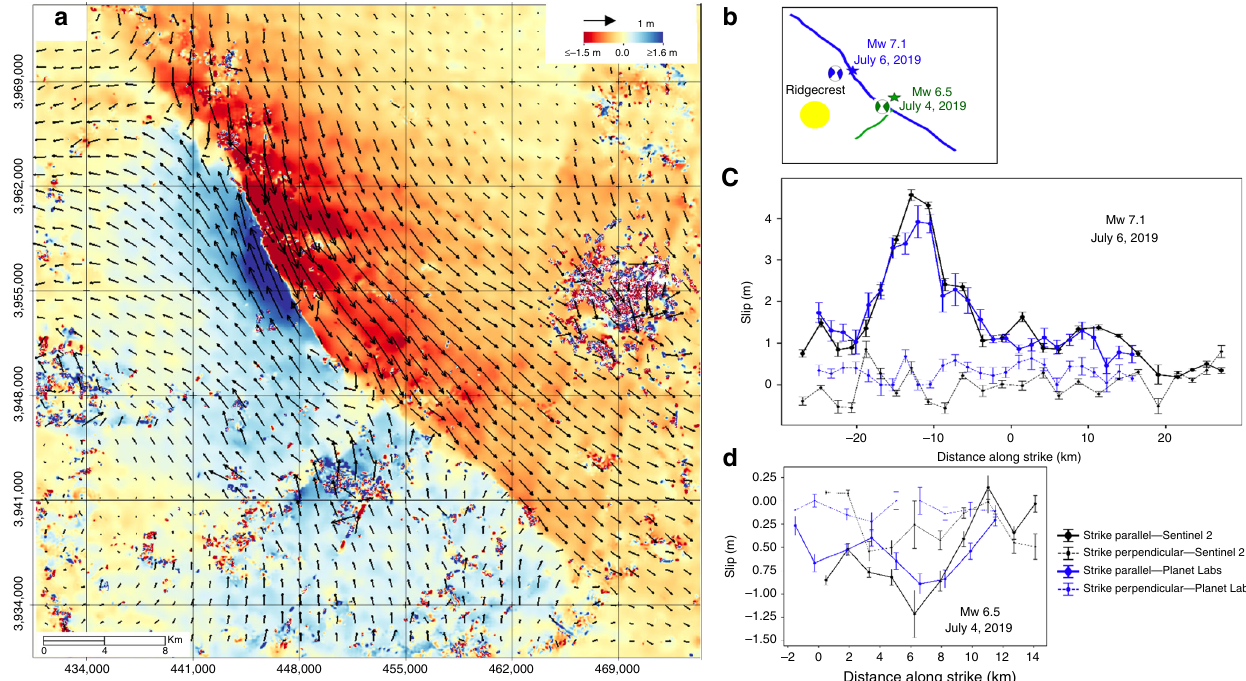
Fig. 2 Surface deformation due to the 2019 Ridgecrest earthquakes measured from optical image correlation. a Surface displacement (arrows) and amplitude of NS component (shading) measured from correlation of Sentinel-2 images acquired on June 28 and July 08, 2019. b Simpli fi ed fault ruptures derived from the Sentinel-1 and Planet Labs data with GCMT focal mechanisms and epicentres of the M w 7.1 and M w 6.5 earthquakes from the USGS. c Strike-parallel (positive for right-lateral) and strike-perpendicular (positive in extension) component of surface fault slip measured from the Sentinel-1 and Planet Labs image. d Same as c for the M w 6.5